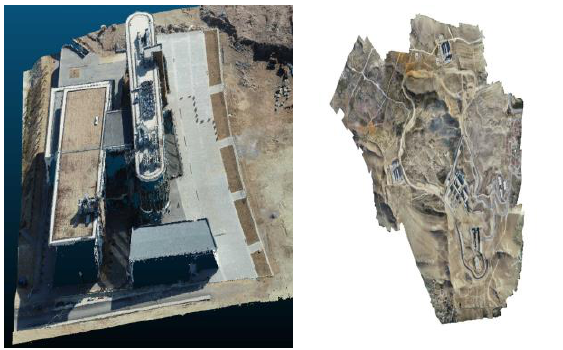
Figure 6/a . SBIF UAV Data. Figure 6/b. Campus Orthophoto.